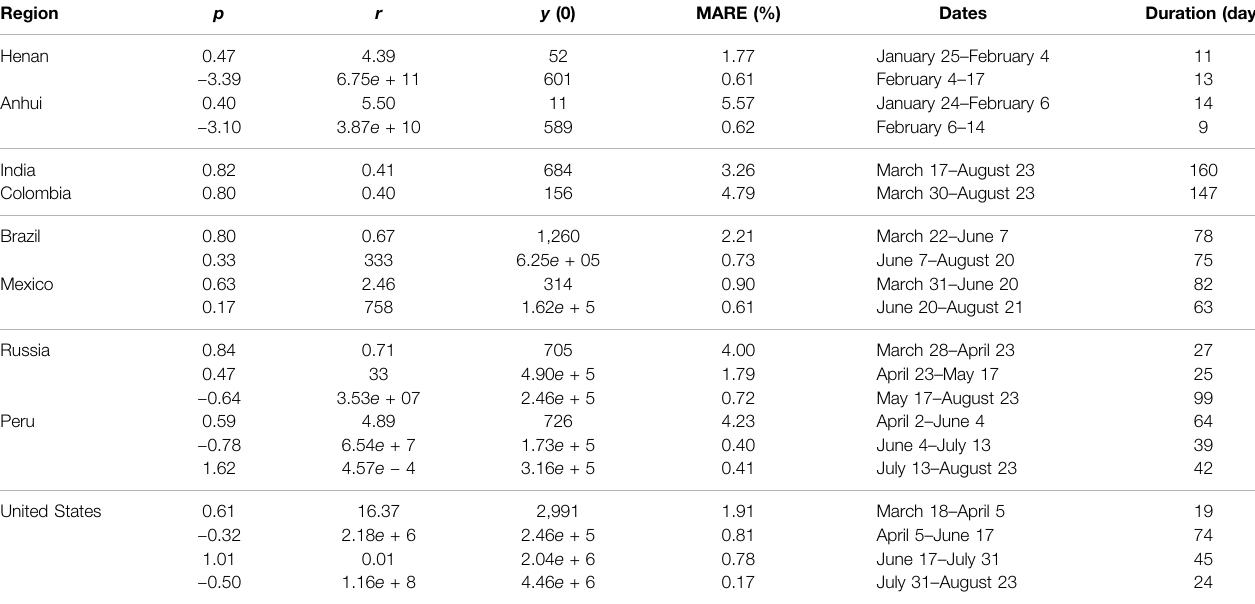
TABLE 1 | The fi tting parameters for different stages of different regions and countries. The MARE, dates, and duration are also listed for each case.